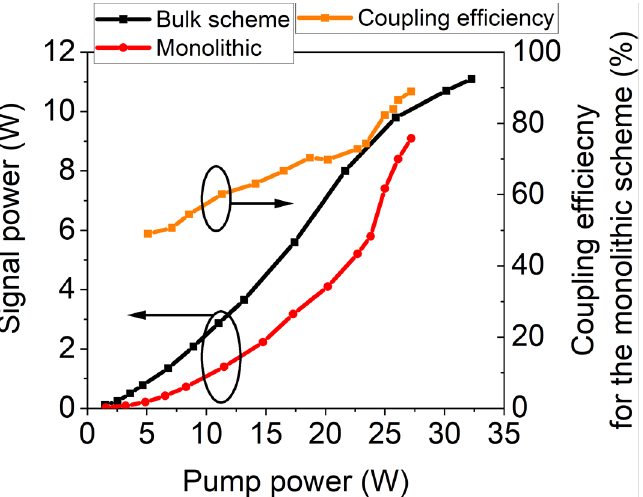
Figure 6. Dependence of signal power on pump power for bulk optics and side-coupled monolithic schemes and coupling efficiency for the monolithic scheme. schemes and coupling efficiency for the monolithic